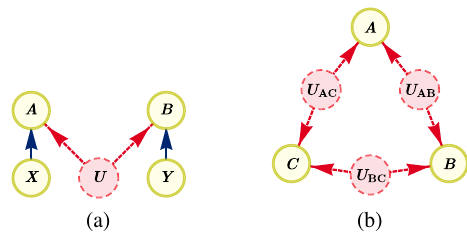
FIG. 1. DAG representation of different causal scenarios. The red dashed circles are latent nodes, and the yellow single-lined circles denote observed variables. (a) The Bell scenario is one of the simplest causal structures exhibiting a classical-quantum gap, that is, where there exist distributions that can be realized upon taking the latent nodes to represent quantum states (subsequently denoted as U ¼ ρ ) but not when the latent nodes are taken to represent distributions over classical hidden variables (subsequently denoted as U ¼ Λ ). (b) The triangle scenario, with three observed and three latent nodes, also presents a classical- quantum